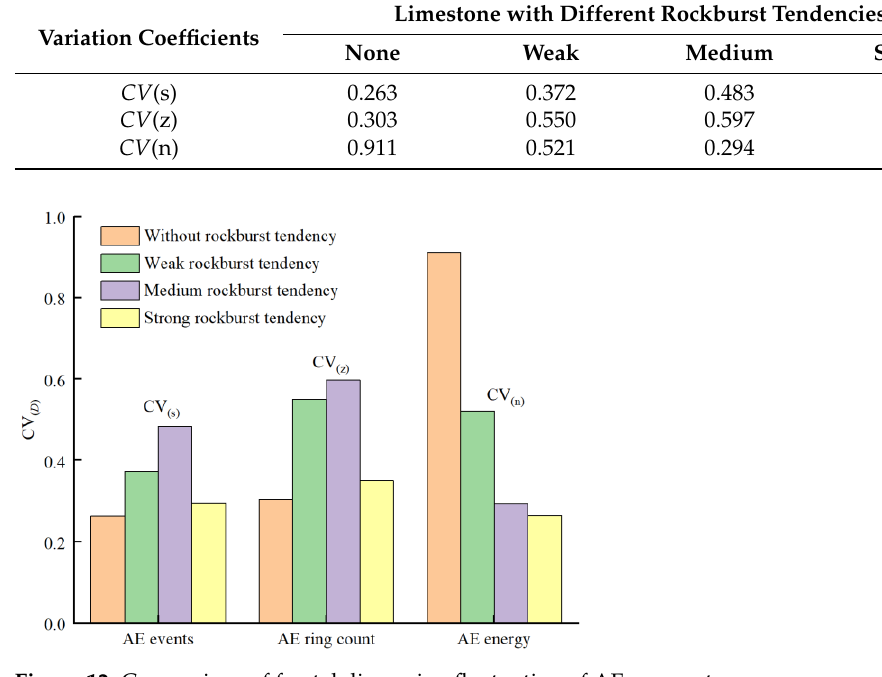
Table 6. Calculation results of variation coefficients.